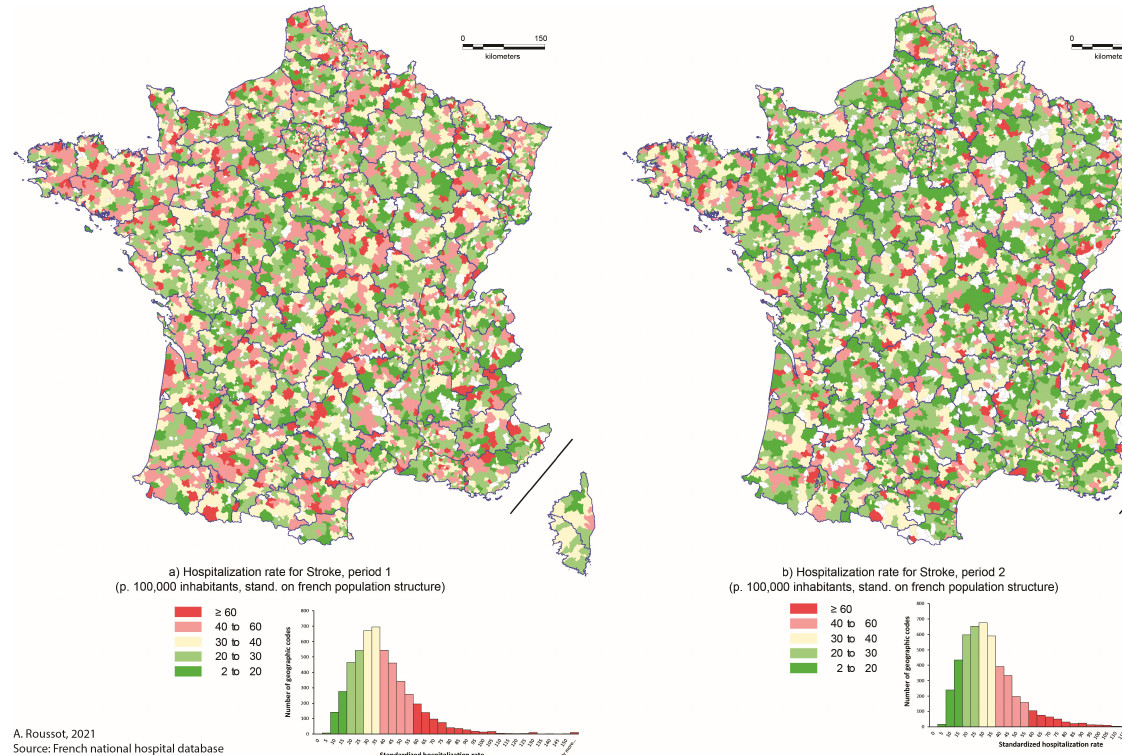
Figure 4. Hospitalization rate for stroke by periods and postal zip-codes in 2020. Legend: Hospitalization rates are standardized on French population structure and expressed per 100,000 inhabitants. Periods are defined as: ( a ) period 1 = before the lockdown (1 January to 16 March 2020), ( b ) period 2 = during the lockdown (17 March to 10 May 2020) and ( c ) period 3 = after the lockdown (11 May to 30 September